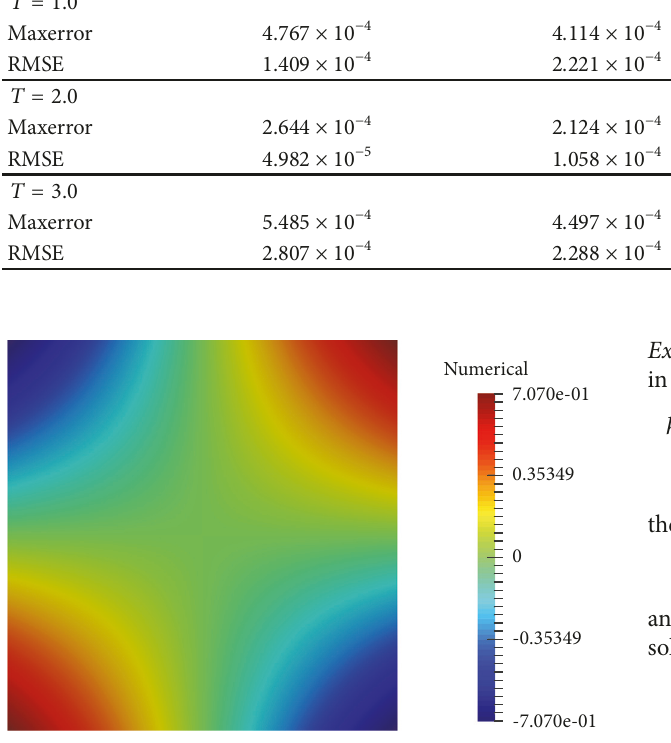
Figure 10: The numerical solutions of 𝑢(𝑥, 𝑦, 0) .